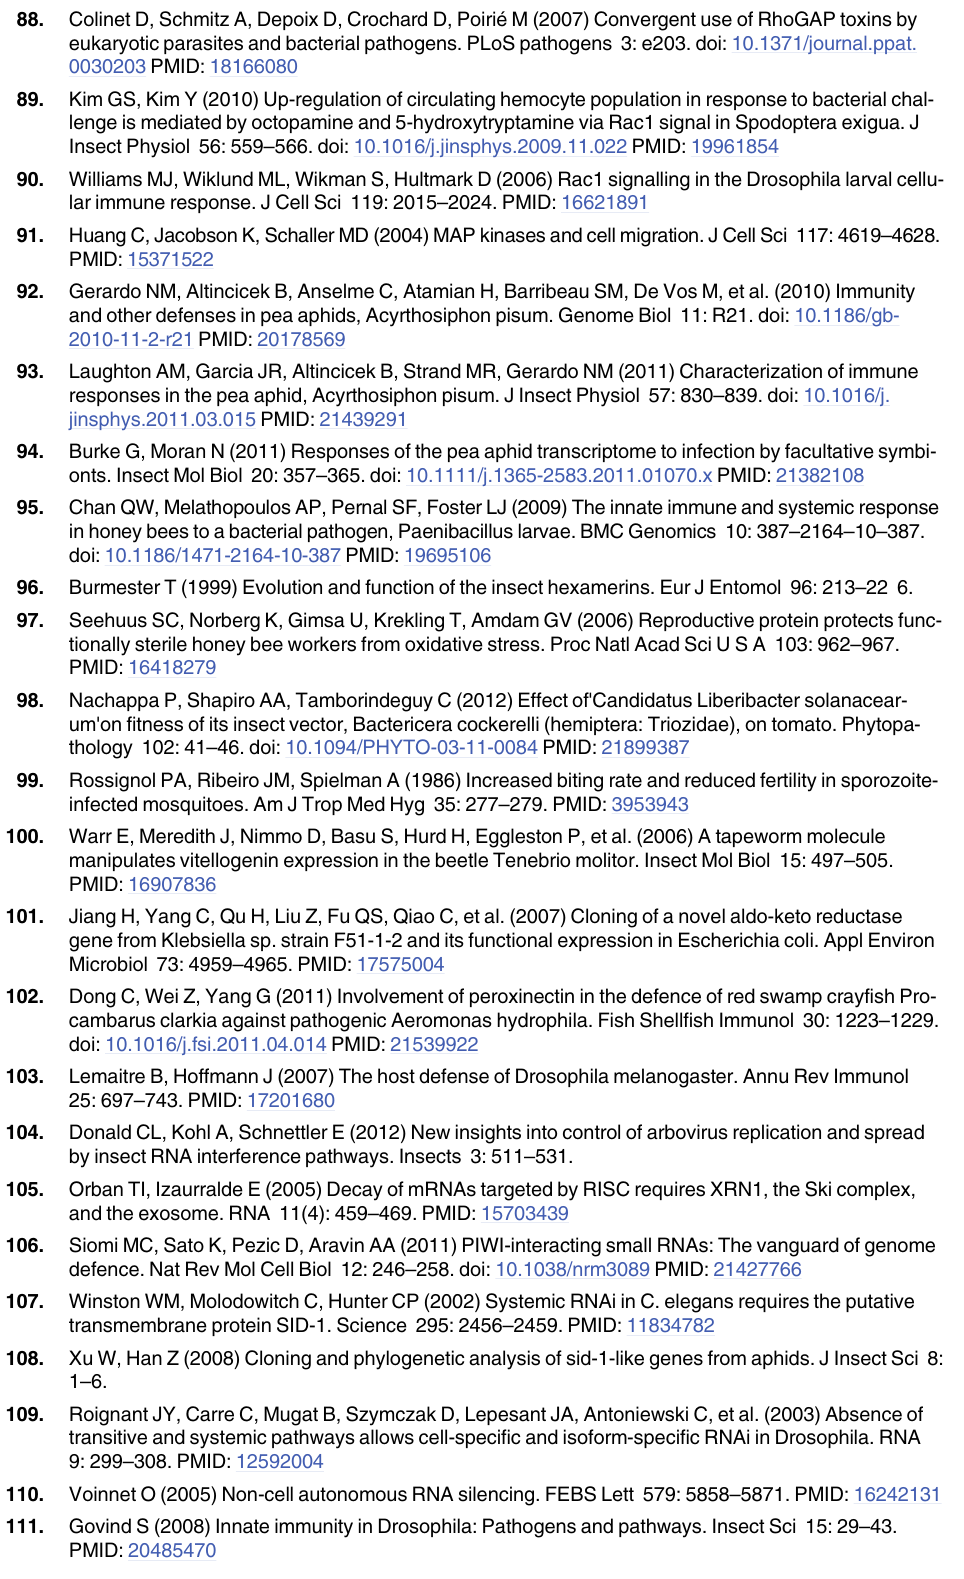
PLOS ONE | DOI:10.1371/journal.pone.0130328 June 19,